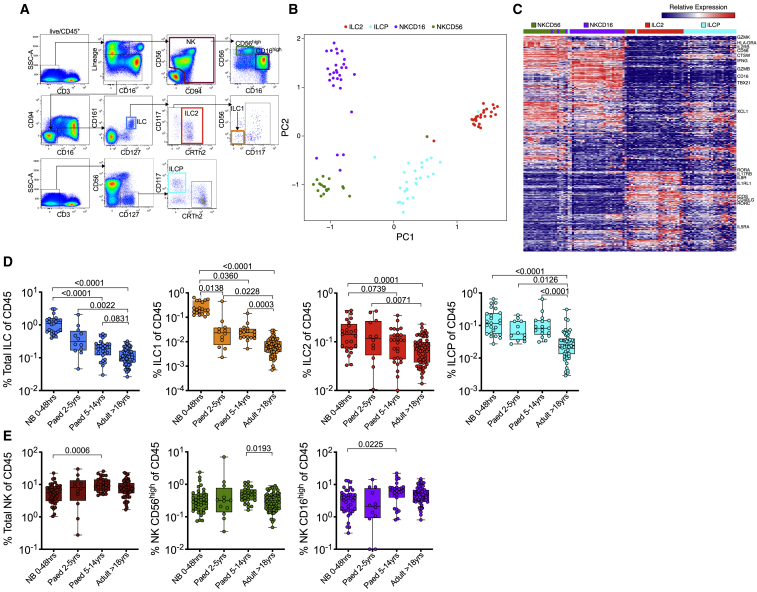
Circulating ILC Populations Decrease during the Course of Immune Maturation(A) Gating strategy including lineage markers (CD3, CD4, CD11c, CD14, CD19, CD34, CD303, TCRγδ, TCRαβ) to identify two dominant NK populations defined by CD56high(green) and CD16high (purple) and three ILC subsets: ILC1 (orange), ILC2 (red), and ILCP (light blue).(B) Principal component analysis (PCA) and heatmap shown for each replicate for each participant (see Table S1).(C) DEGs among ILC2, ILCP, CD56high (NKCD56), and CD16high (NKCD16) NK cell populations from four HIV-negative and six HIV-positive pediatric subjects.(D) Frequencies of total helper ILC subsets as defined in (A), comparing HIV-negative newborn (NB) (n = 39), pediatric (2–5 years, n = 12), pediatric (>5 years, n = 25), and adult (n = 62) individuals expressed as percentage of total CD45+ lymphocytes.(E) As in (C) but showing frequencies of total NK and subset-specific differences between pediatric and adult subjects.p values by Dunn’s multiple comparisons test.